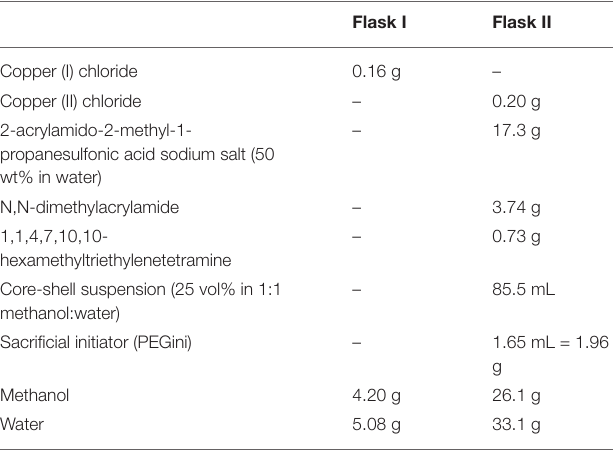
TABLE 2 | Mass/volume of each component added to the synthesis of the charged surface